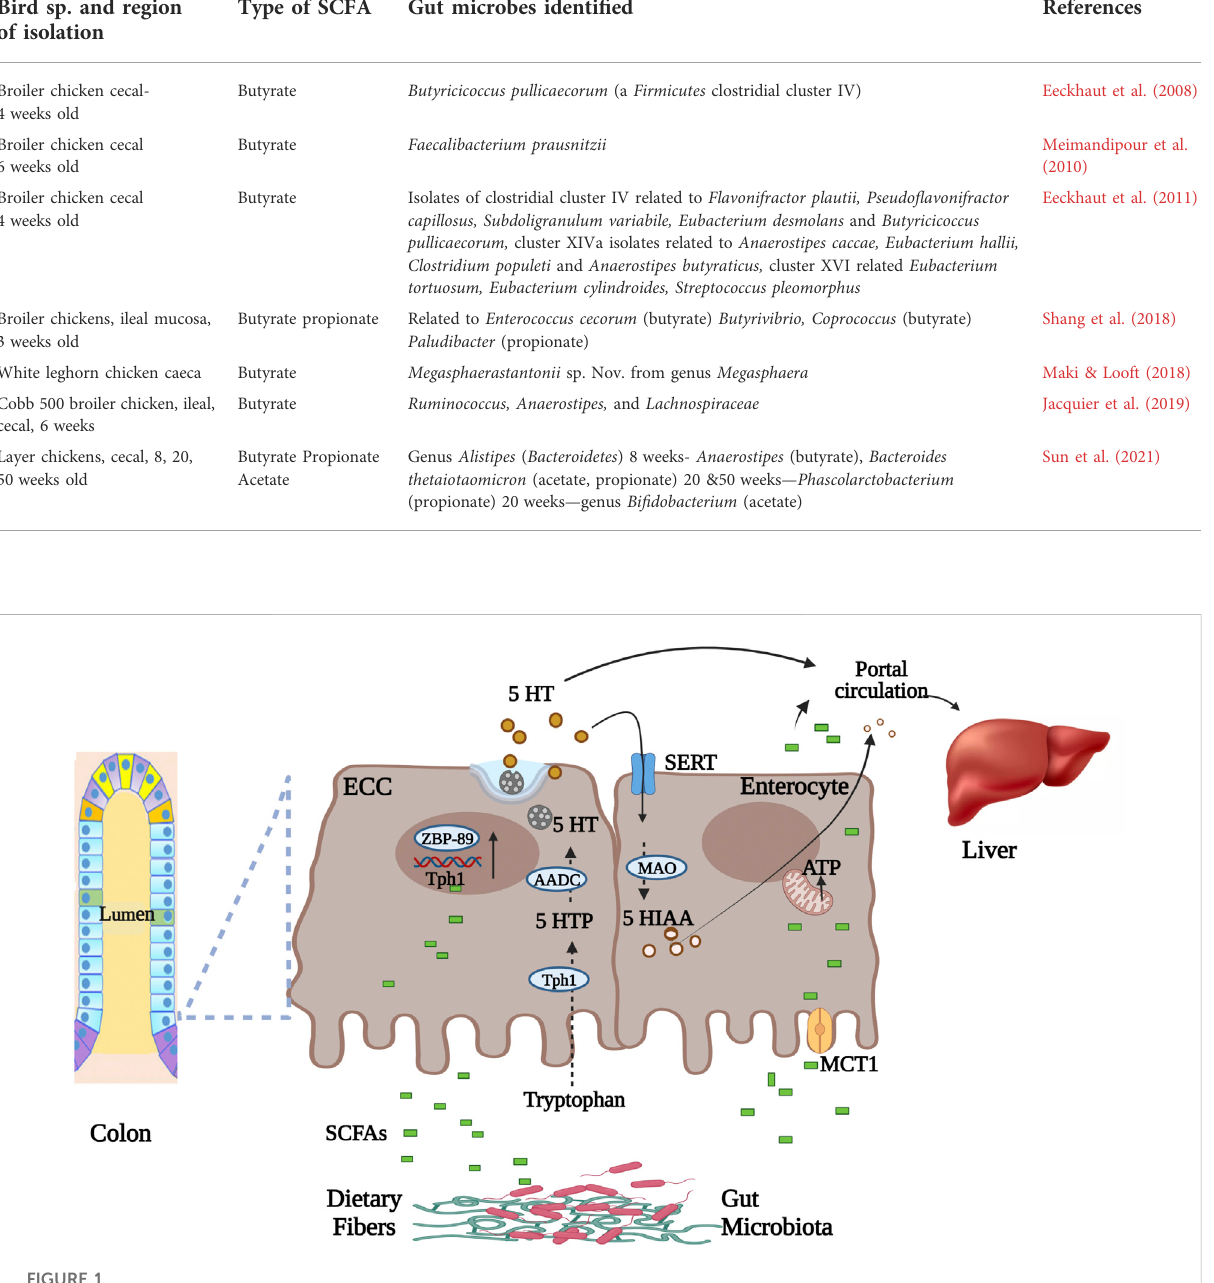
TABLE 2 Selected studies of SCFA-producing gut microbes in chickens.